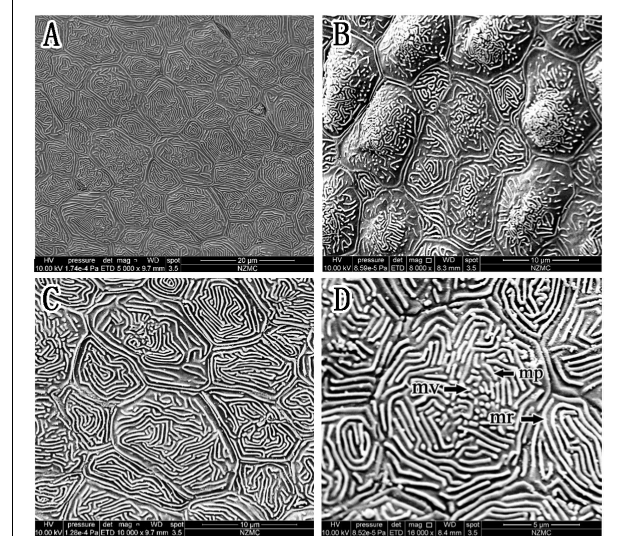
FIGURE 6 | (A–D) Corneal epithelial cells of S. histophorus under a scanning electron microscope. The type and microstructure of the epithelial cells are shown (mp, microplicae; mv, microvilli; mr,